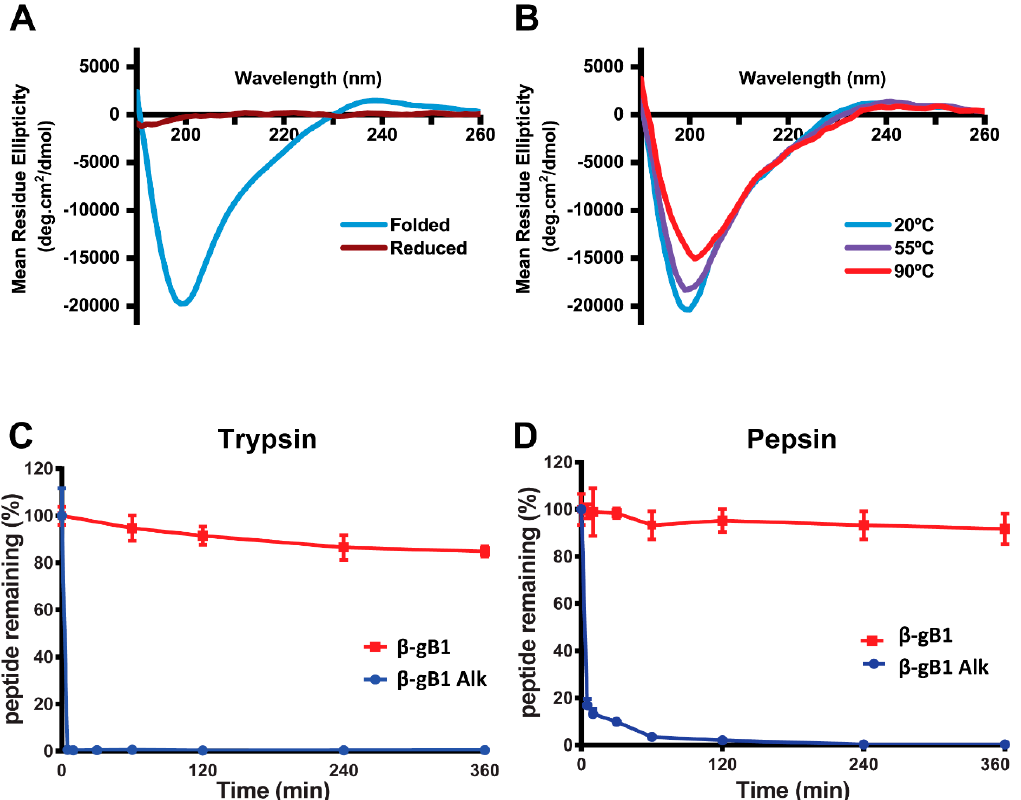
Figure 1. Comparison of the stability of the folded β -gB1 and S -reduced and S -alkylated forms. ( A ) Far-UV CD spectra of folded and S -reduced β -gB1 peptides at 20 °C. ( B ) Far-UV CD spectra of the folded β -gB1 peptide at 20, 55 and 90 °C. Proteolytic stability of β -gB1 against ( C ) trypsin and ( D ) pepsin for six hours in the buffer (pH 7.8) at 37 °C. The S -alkylated β -gB1 ( β -gB1 Alk) was used as a control.